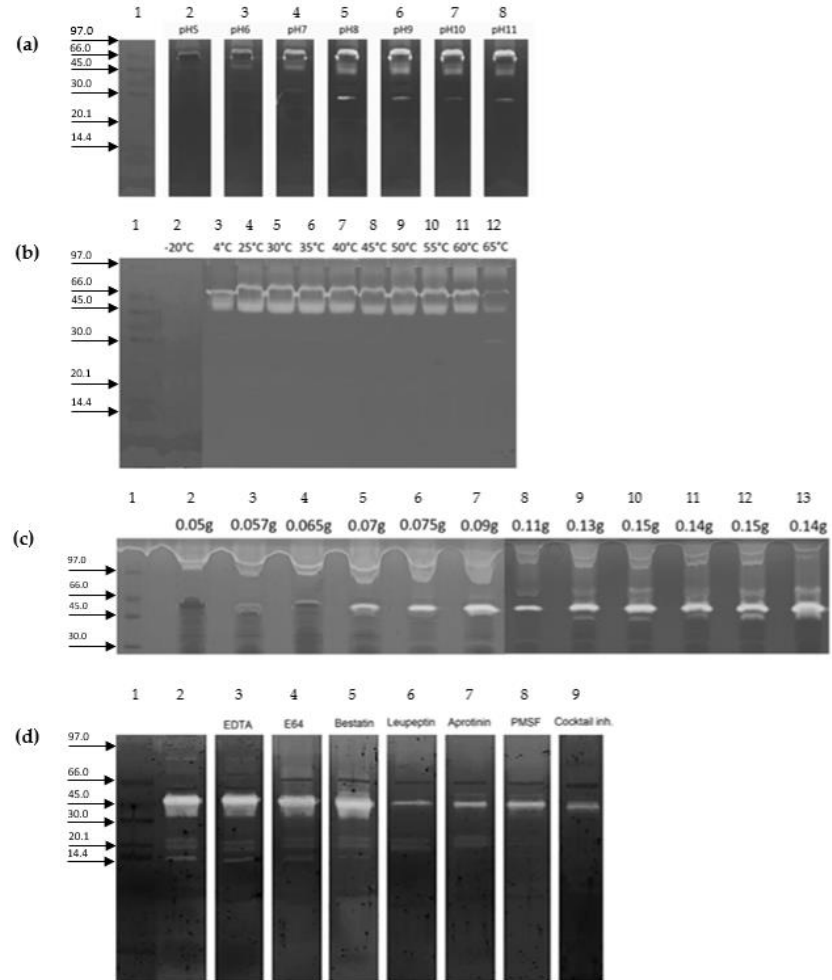
Figure 2. Zymography of worker-fate larvae protein extract (10% T, 2.6% C), marker low range. ( a ) pH activity of PS4: lane 1, Marker low range in kDa; lanes 2 – 8, worker-fate larval extract incubated with buffer at different pH values (5 – 11). ( b ) Thermal activity of PS4: lane 1, Marker low range; lanes 2 – 12, worker-fate larval extract incubated at temperature ranged from − 0 °C to 65 °C. ( c ) PS4 activity during worker-fate larvae development: lane 1, Marker low range; lanes 2 – 10, worker-fate larval extract at different weights (0.05 – 0.15 g); lanes 11 – 12, protein extract of sealed worker-fate larvae in the dorsal position with different weights (0.14 g and 0.15 g, respectively); lane 13, protein extract of sealed worker-fate larvae in the ventral position with a weight of 0.14 g. ( d ) The effect of the inhibitor of proteases on PS4: lane 1, marker low range; lane 2, worker-fate larval extract without protease inhibitors; lanes 3 – 9, worker-fate larval extract incubated with proteases inhibitors.